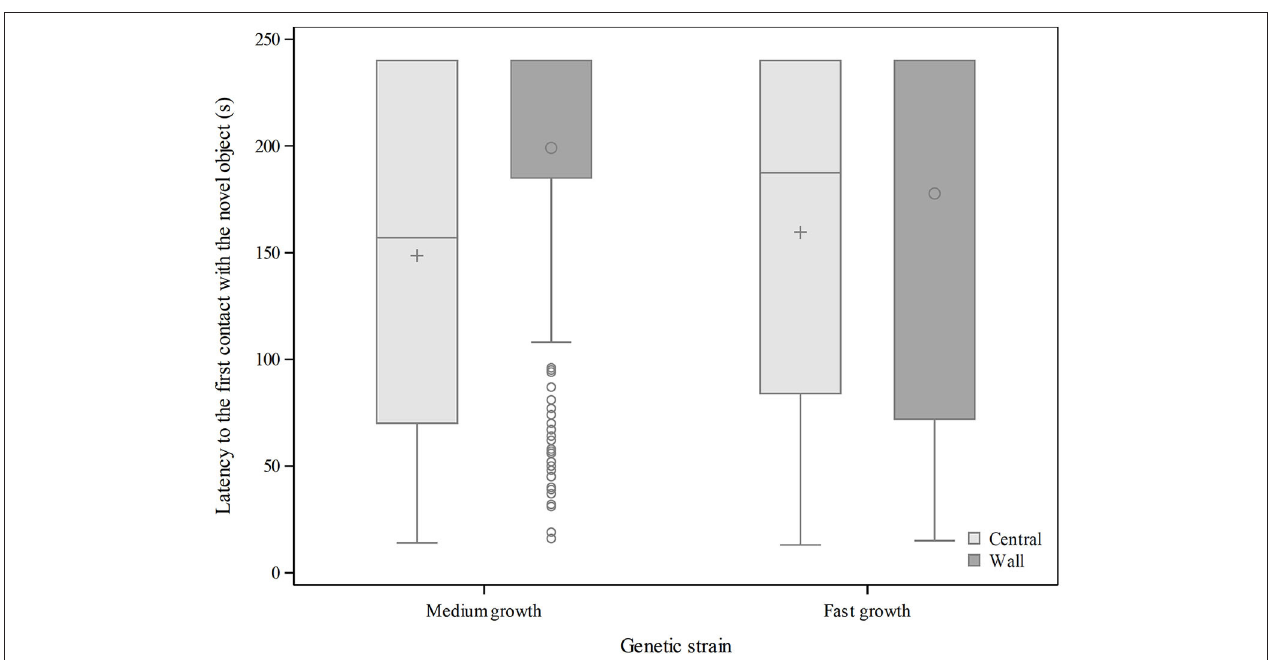
FIGURE 5 | Interaction between the genetic strain and the assessment house location on the latency to the first contact with the novel object. Boxes show interquartile ranges, and whiskers represent minimum and maximum values. Symbols ( + , ◦ ) inside boxes indicate the mean value, while symbols ( + , ◦ ) outside whiskers represent